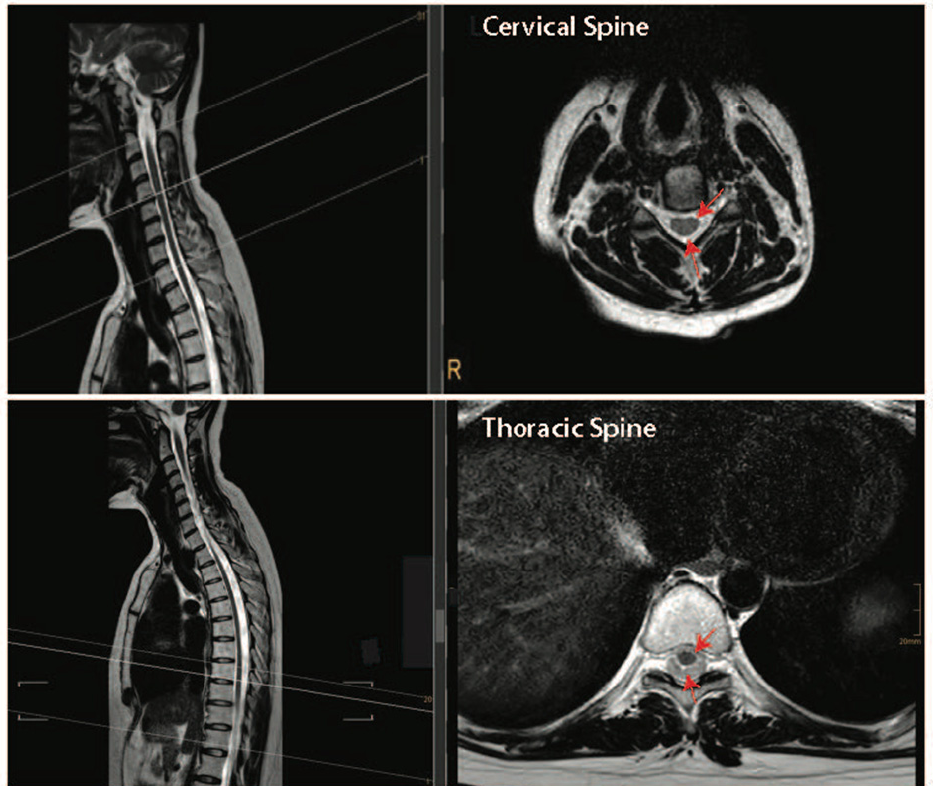
Figure 4. Intact cervical and thoracic spinal cord tissue can float freely within the spinal column in humans. Top panel—T2-weighed sagittal and cross-sectional images of the cervical spine. Bottom panel—T2-weighed sagittal and cross-sectional images of the thoracic spine. Dark structures where the red arrows are pointing are the spinal cord tissue and the lighter areas depict cerebral spinal fluid-filled subarachnoid space. Images are courtesy of Dr. Tobias Prasse.